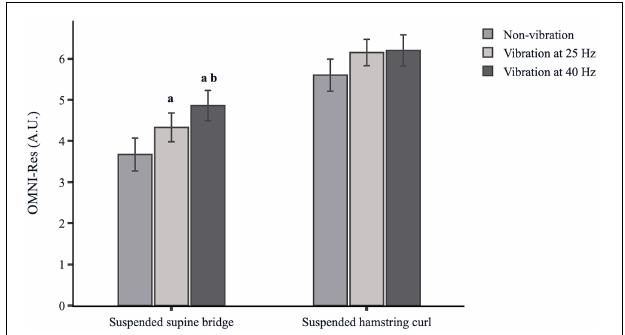
FIGURE 5 | OMNI-Res (mean ± SE) for suspended supine bridge and suspended hamstring curl under non-vibration, vibration at 25 Hz and vibration at 40 Hz conditions. Each bar represents the mean, and the error bar represent the standard error of the mean (SE). A.U., Arbitrary units; a significantly different with non-vibration condition; b significantly different with vibration at 25 Hz